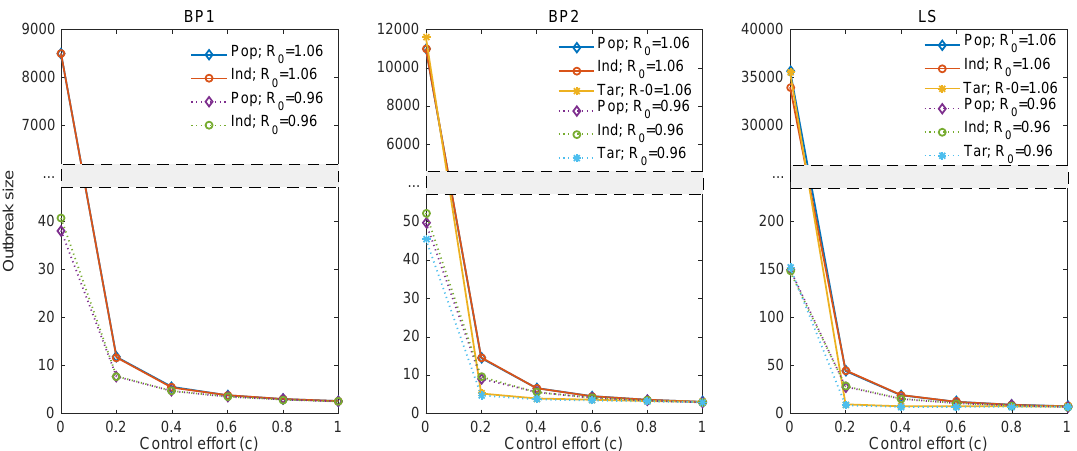
Figure 8. The impacts of control efforts on the outbreak size under the three models: solid lines indicate higher R 0 and dashed lines indicate lower R 0 . Population control is shown with blue and purple lines, random individual control is shown with red and green lines, and targeting individual control is shown with yellow and magenta lines.